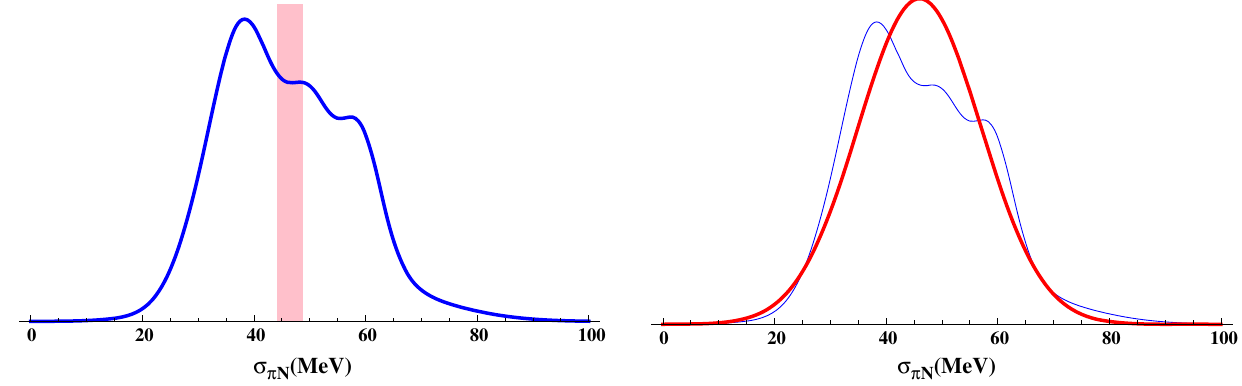
Fig. 3 Left panel: Ideogram combining all values of (cid:7) π N from Table 1. The vertical (pink) bar corresponds to the estimate (23). Right panel: The same ideogram compared with a (red) Gaussian centred at (cid:7) π N = 46 MeV with error σ = 11 MeV